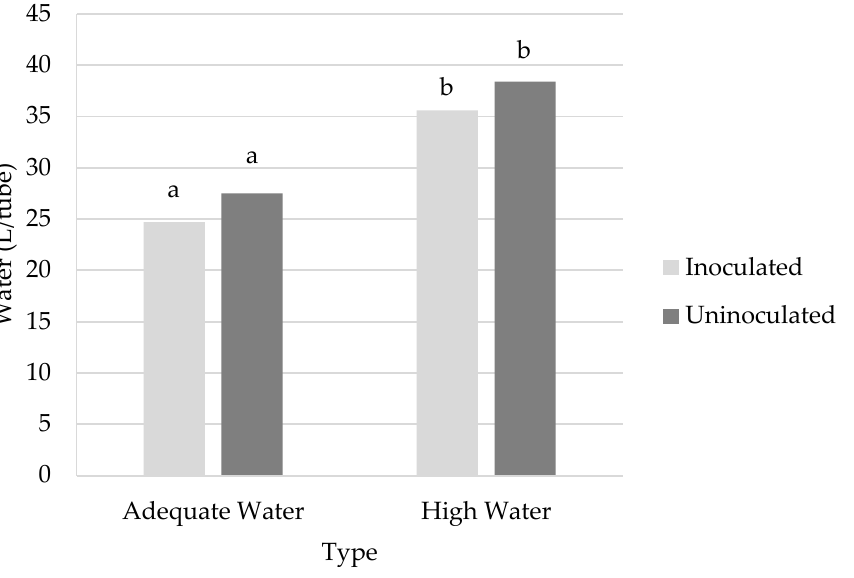
Figure 1. Total gravimetric water use of growth tube (population of four wheat plants) in experiment exploring effect of FCR (Inoculated and Uninoculated) and water (adequate water and high water) on grain yield. Bars with different letters indicate significant differences, p < 0.05.